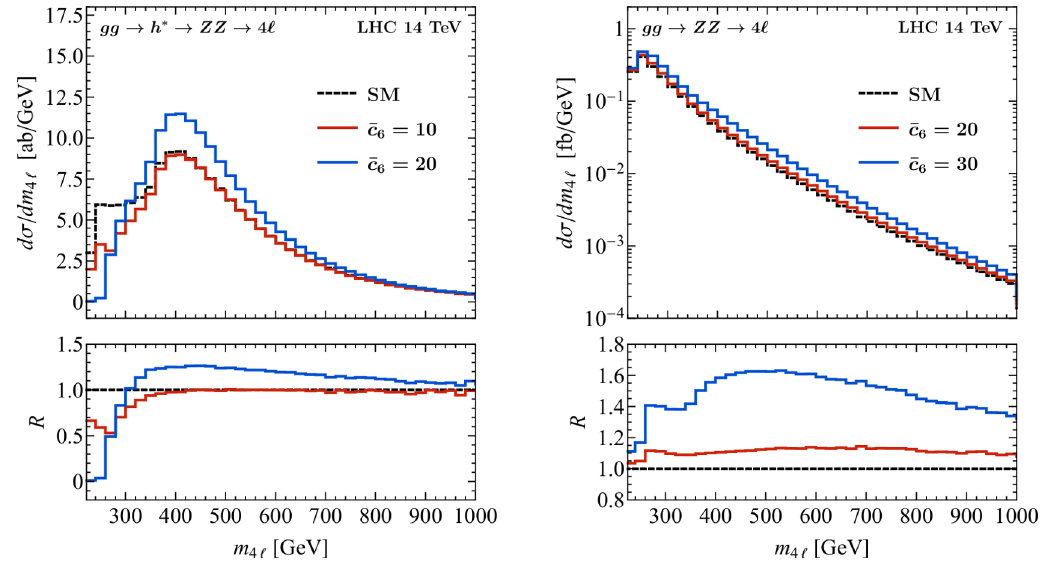
Figure 3. Left: m 4 ‘ distributions for the Higgs signal in the SM (dashed black) and including the O ( λ ) corrections calculated in section 3 assuming ¯ c 6 = 10 (solid red) and ¯ c 6 = 20 (solid blue). Right: m 4 ‘ spectra including the Higgs signal, the continuum background and their interference in the SM (dashed black). The results for the two BSM scenarios corresponding to ¯ c 6 = 20 (solid red) and ¯ c 6 = 30 (solid blue) are also displayed. All distributions are obtained at LO in QCD assuming √ pp collisions at s = 14 TeV . The lower panels show the ratios between the distributions and the corresponding SM predictions. Consult the main text for further